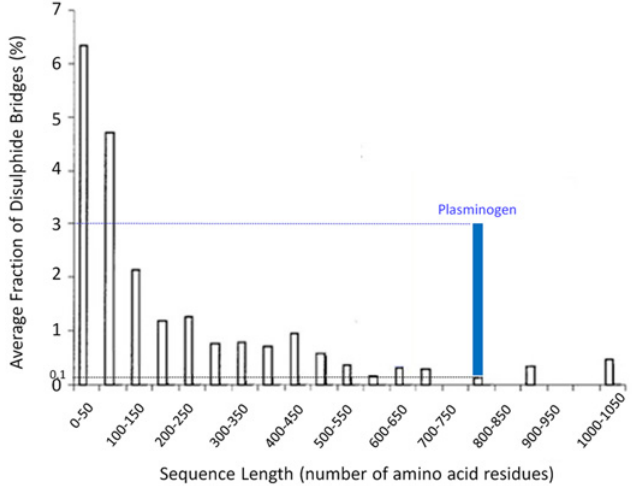
Fig 4. Dependence of the average fraction of disulphide bridges on protein chain length. The fraction of disulphide bridges was obtained by dividing the number of disulphide bridges found in a protein by the protein sequence length (number of amino acids) multiplied by 100. The fraction of disulphide bridges estimated for human plasminogen (in blue, 3.1%, for 767 amino acids) is much higher than what would be expected for a protein of about that length (0.1% for 700 – 750 amino